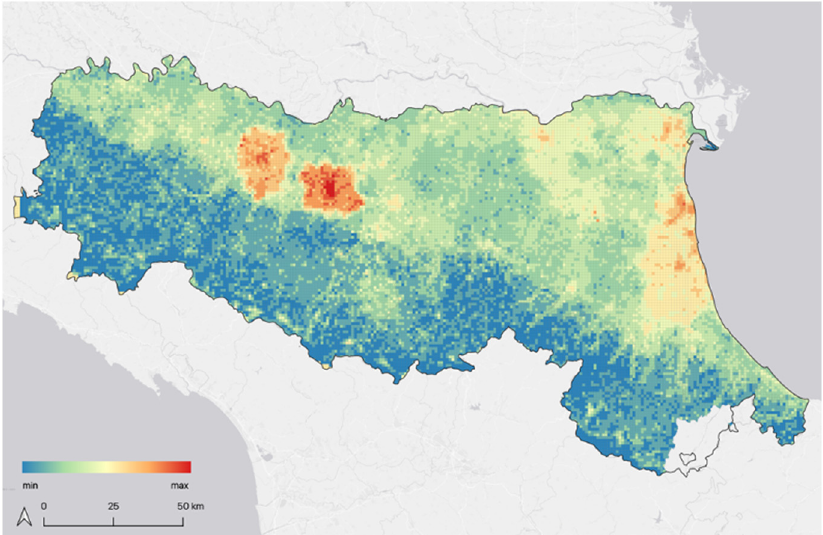
Figure 4. GHG balance map. In this image, as the spectral gradient changes towards red, areas with a positive GHG balance are